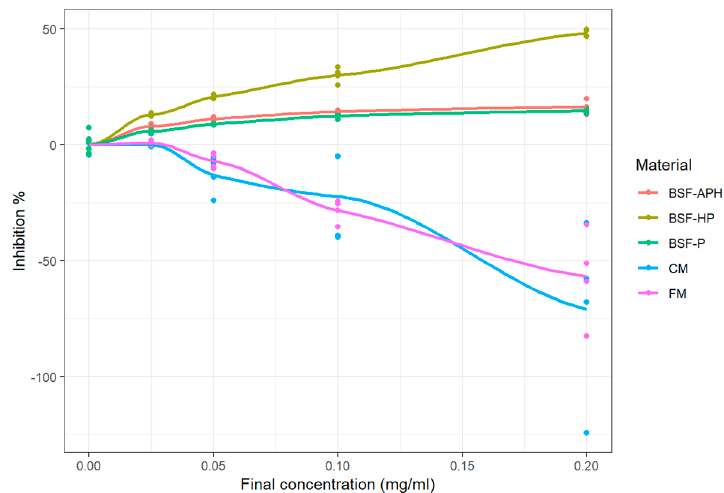
Figure 1. DPPH (2,2-diphenyl-1-picrylhydrazyl) radical scavenging activity of PureeX TM (BSF-P), PureeX proTM (BSF-HP), ProteinAX proTM (BSF-APH), Chickenmeal (CM), and Fishmeal (FM) (n = 3).